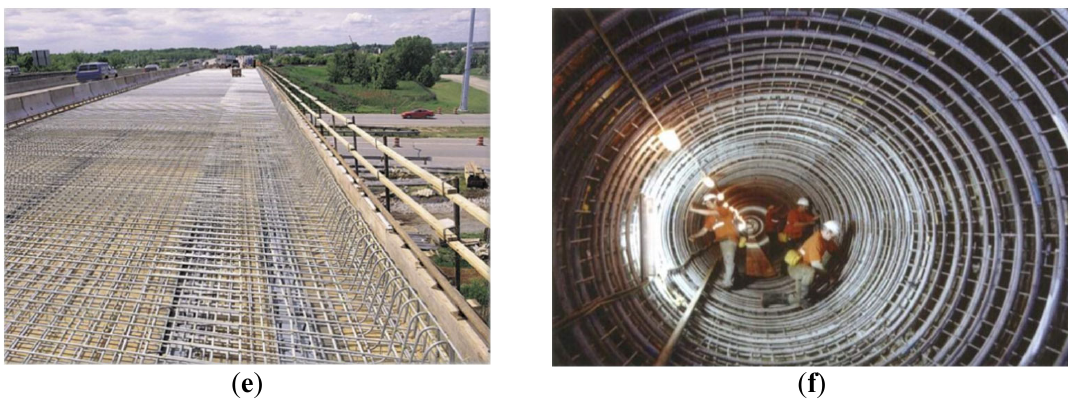
Figure 11. Applications of coated reinforcements: ( a ) Sewerage outfall tunnels, ( b ) Sydney Opera House, ( c ) The Biggs Rapids/Sam Hill Bridge ( d ) I-90 Dresbach Bridge Replacement ( e ) Ashland Avenue Bridge, ( f ) Hydro-Electric Power Station [16,43,155,159].